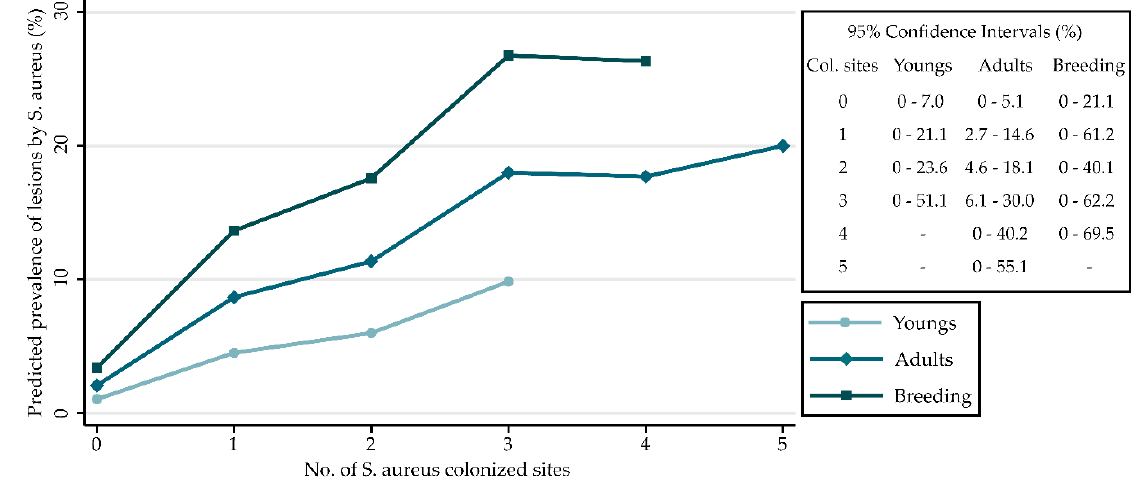
Figure 1. Expected prevalence of S. aureus lesions: Predicted prevalence of lesions due to S. aureus based on the number of colonized anatomical sites and age categories. Confidence intervals are shown in the table.